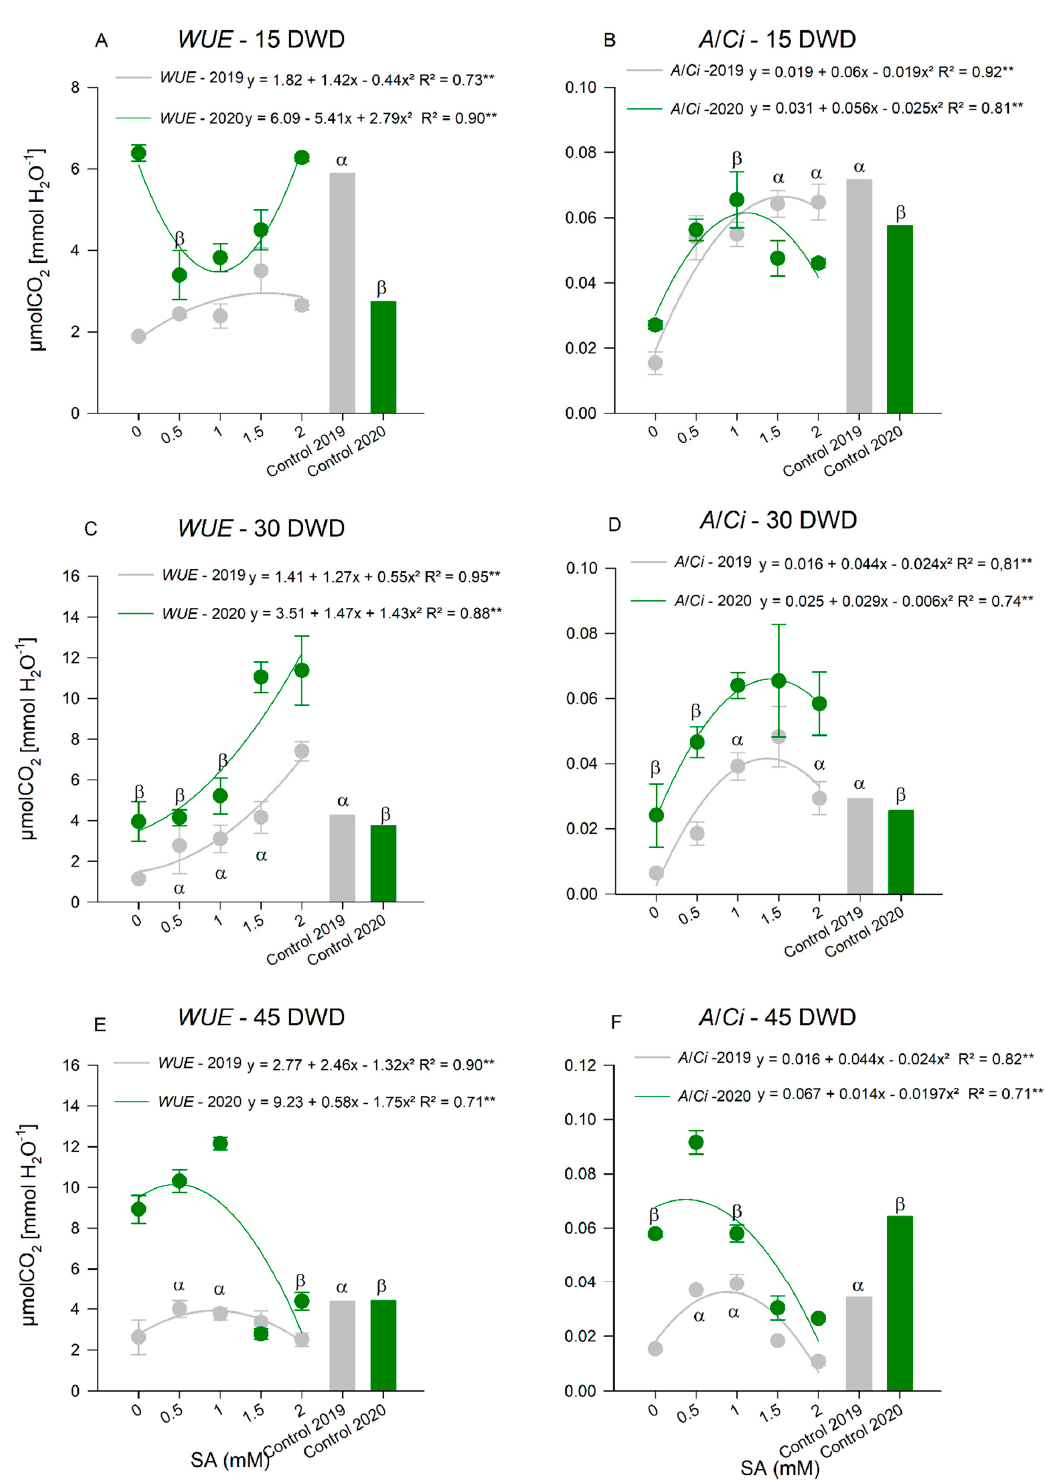
Figure 4. Water use efficiency ( WUE ) at 15 ( A ), 30 ( C ), and 45 ( E ) days of water deficit (DWD); carboxylation efficiency ( A/Ci ) at 15 ( B ), 30 ( D ), and 45 ( F ) DWD of tomato plants submitted to the application of salicylic acid (SA) doses in two consecutive years (2019 and 2020). ** Highly Significant at 5% probability; α Indicates that there was an equal and significant effect between treatments by Dunnett’s Test at 5% probability in the 2019 cycle and β in the 2020 cycle. The bars show the standard deviation. n = 4 (number of